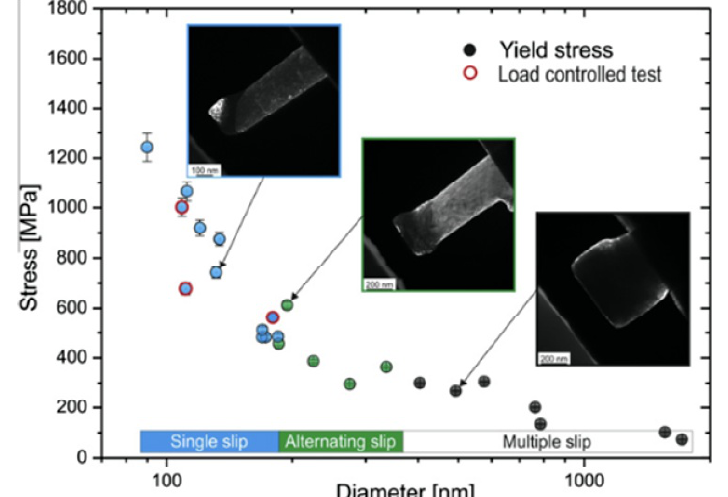
Fig. 20. Yield stress results of compressing Cu (1 0 0) samples ranging in diameter from 90 nm to 1700 nm. Besides the size e û ect, a change in the deformation morphology is shown indicated by differently colored symbols. Reprinted with permission from Kiener D, Minor AM. 2011. Source-controlled yield and hardening of Cu (100) studied by in situ transmission electron microscopy. Acta Materialia 59, [223]: (c) 2011 Elsevier